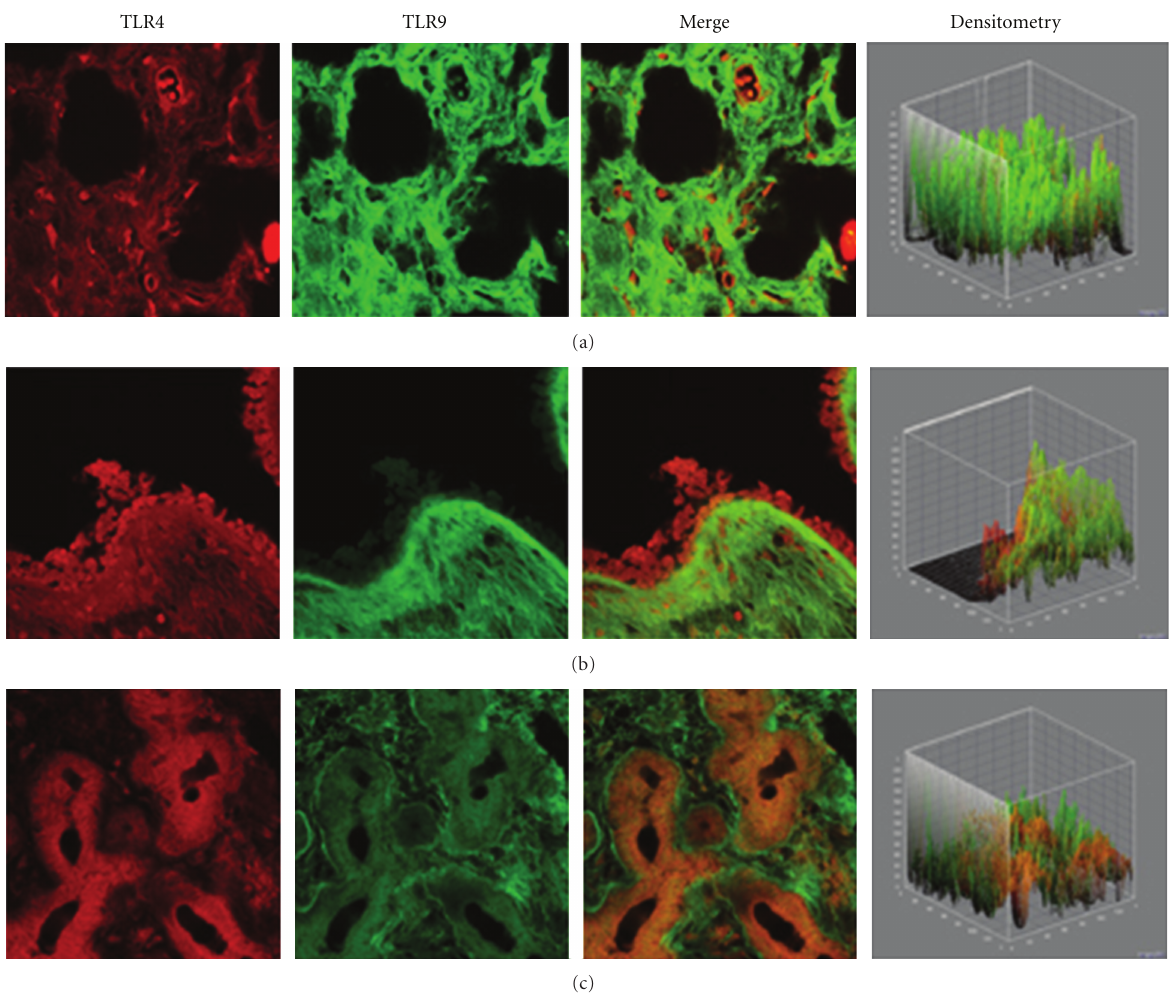
Figure 1: TLR4 and TLR9 expression in healthy turbinates. Confocal analysis showing TLR4 and TLR9 expression at the submucosal layer (a), nasal glands (b), and at the epithelial level (c). Note the strong TLR4 localization at both the epithelial and stromal levels, while TLR9 was localized at the stromal level. ×